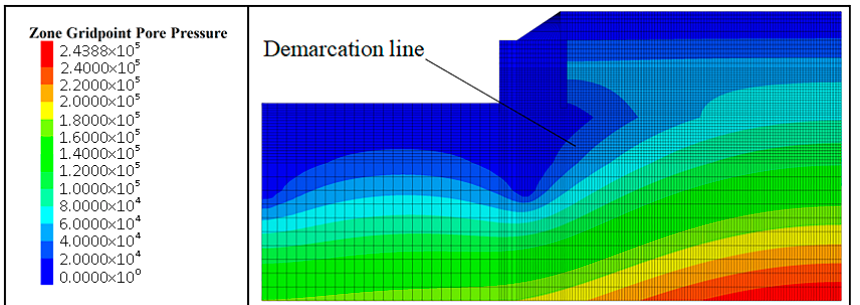
Figure 19. Final pore water pressure distribution.